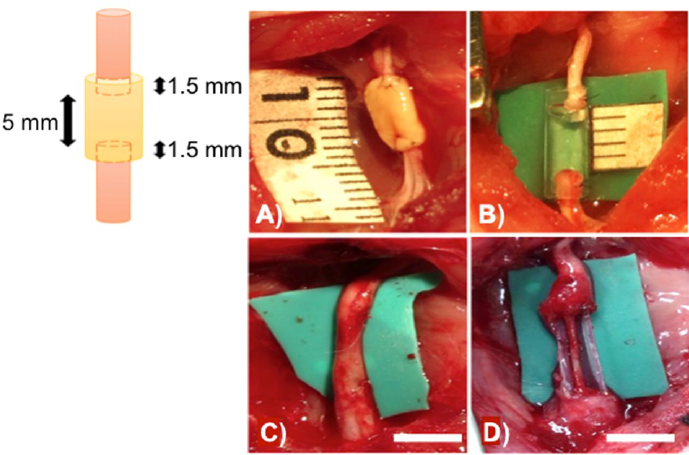
Figure 3. ( A ) Bio 3D conduit was implanted into the nerve defect, and the proximal and distal nerve stumps were secured 1.5 mm into the tube to create a 5-mm interstump gap in the conduit. ( B ) The silicone tube with 8 mm length was implanted in the same procedure. ( C ) Regenerated sciatic nerve eight weeks after surgery in the bio 3D group and ( D ) silicone tube. Scale bar in ( C , D ) = 5 mm. Adapted with permission from ref. [32]. Copyright 2017, Public Library of Science.